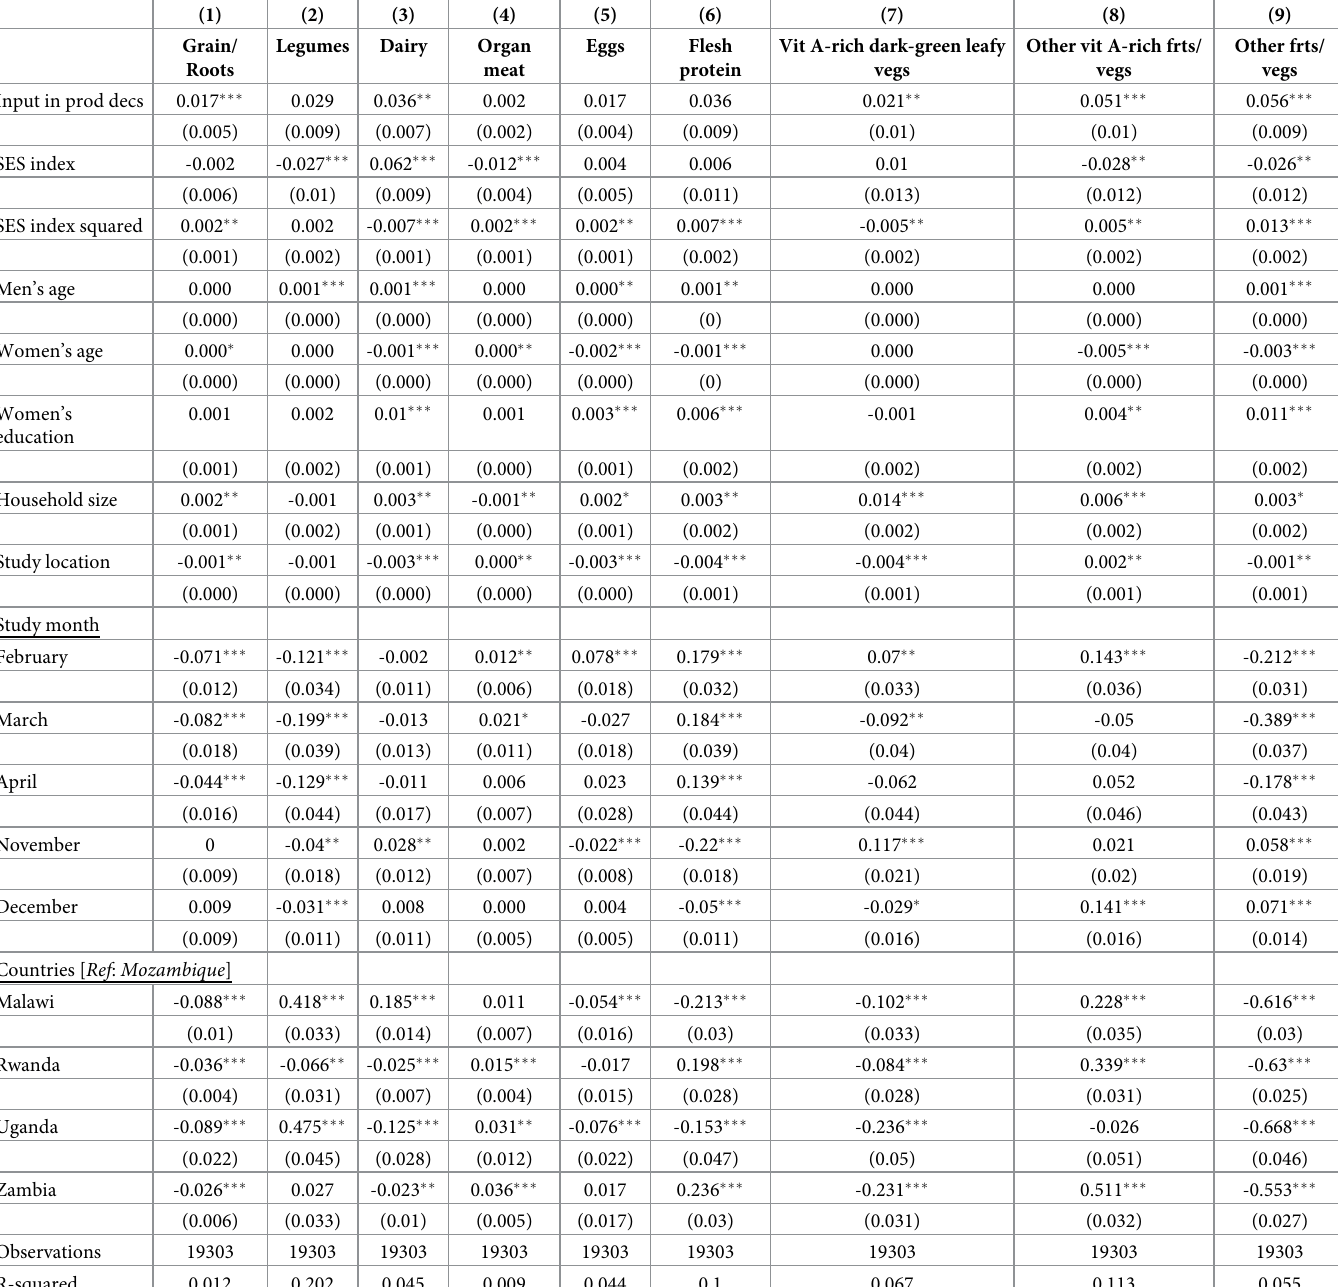
Table 16. LPM regression for food groups consumed–production domain (input in � 2 productive